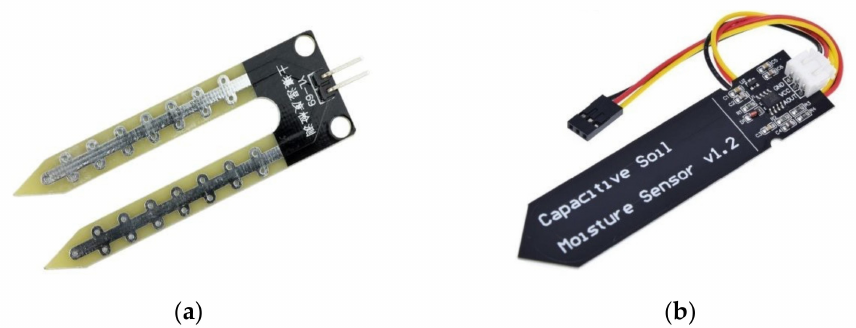
Figure 8. ( a , b ) a typical YL-69 water sensor and a capacitive soil moisture sensor, respectively [86], Courtesy of the Shenzhen Haiwang Sensor Co., Ltd.,